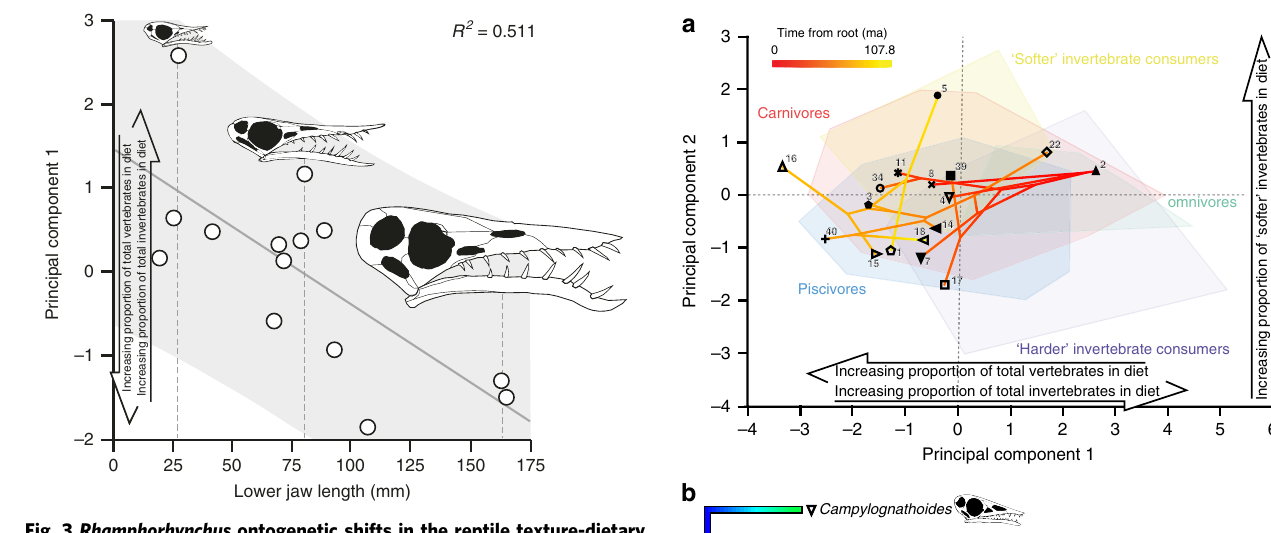
Fig. 3 Rhamphorhynchus ontogenetic shifts in the reptile texture-dietary space. Regression of lower jaw length ( n = 14), as a proxy for specimen size, plotted against PC 1 values from the extant reptile texture-dietary space. The solid grey line denotes the line of best fi t and grey shading denotes the 95% con fi dence intervals. Skull diagrams represent scaled examples of an adult, juvenile and hatchling Rhamphorhynchus , with the grey dashed lines denoting their relative size. These diagrams illustrate the size disparity between sampled life-history stages and are not specimen reconstructions of the datum points they are associated with. See Supplementary Fig. 4 for Rhamphorhynchus ontogenetic shifts in the bat texture-dietary space and the ‘ Methods' for the skull diagram sources.